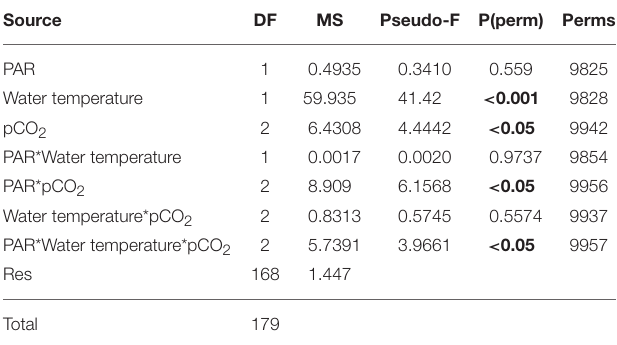
TABLE 4 | Results of PERMANOVA analysis on the separate and interactive effects of pCO 2 , PAR, and water temperature on the net primary production rate of Zostera marina in 2013.